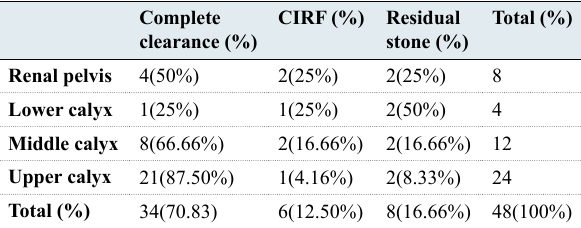
was detected as follows: lower pole 25%; middle pole, 66.66%; Table 3: Success rate according to stone location Complete CIRF (%) Residual Total (%) clearance (%) stone (%) Renal pelvis 4(50%) 2(25%) 2(25%) 8 Lower calyx 1(25%) 1(25%) 2(50%) 4 Middle calyx